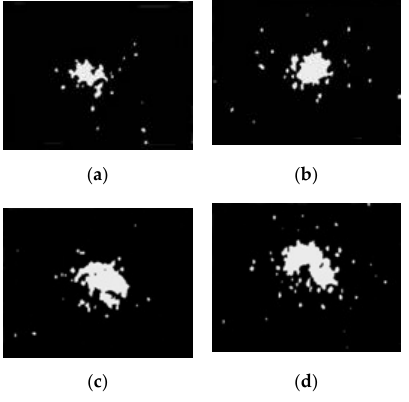
Figure 7. Binary images of grade I to IV contaminated insulators: ( a ) grade I, ( b ) grade II, ( c ) grade III, and ( d ) grade IV.